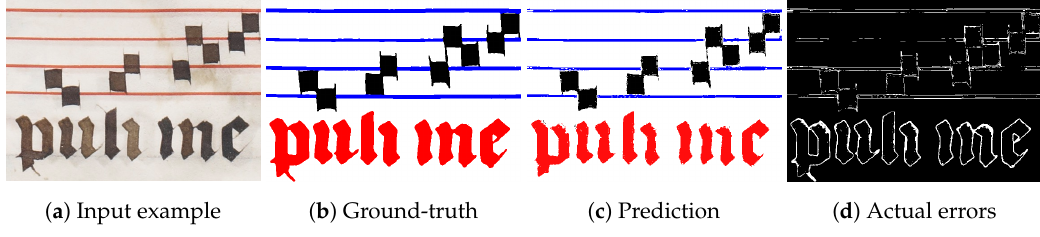
Figure 10. Qualitative example from Salzinnes manuscript of the document processing achieved by the